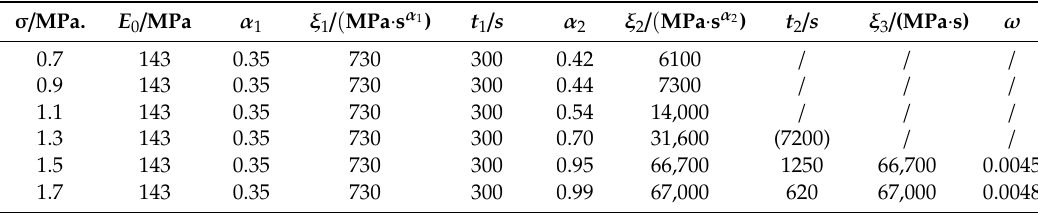
Table 2. Parameters of the creep model for asphalt